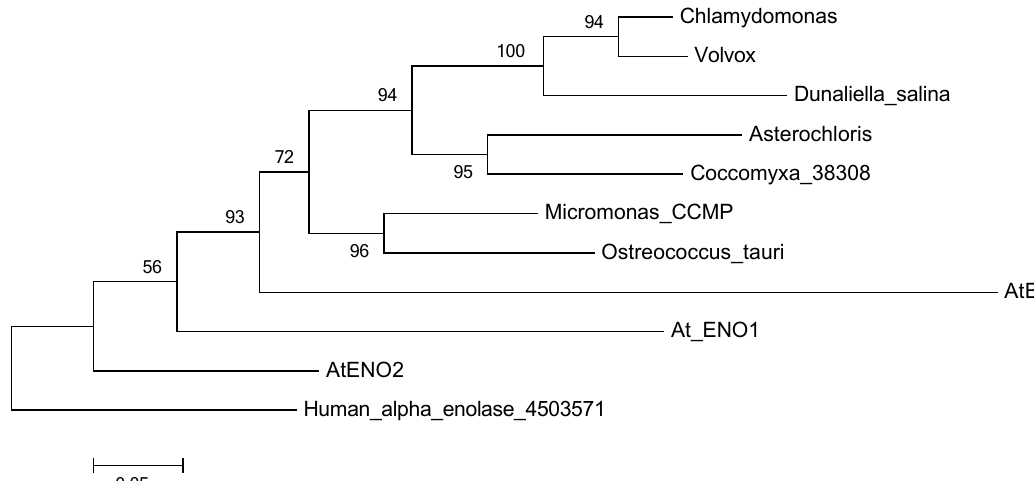
Figure 4. Protein Maximum Likelihood phylogeny reconstruction based on 500 bootstraps of the glycolytic enolase genes including several green algae and the three different glycolytic enolase forms from A . thaliana . Tree was rooted with the human alpha enolase. The multi-functional enolases were not included in this phylogeny, because they are too different from the glycolytic enolases and resulted in very low support